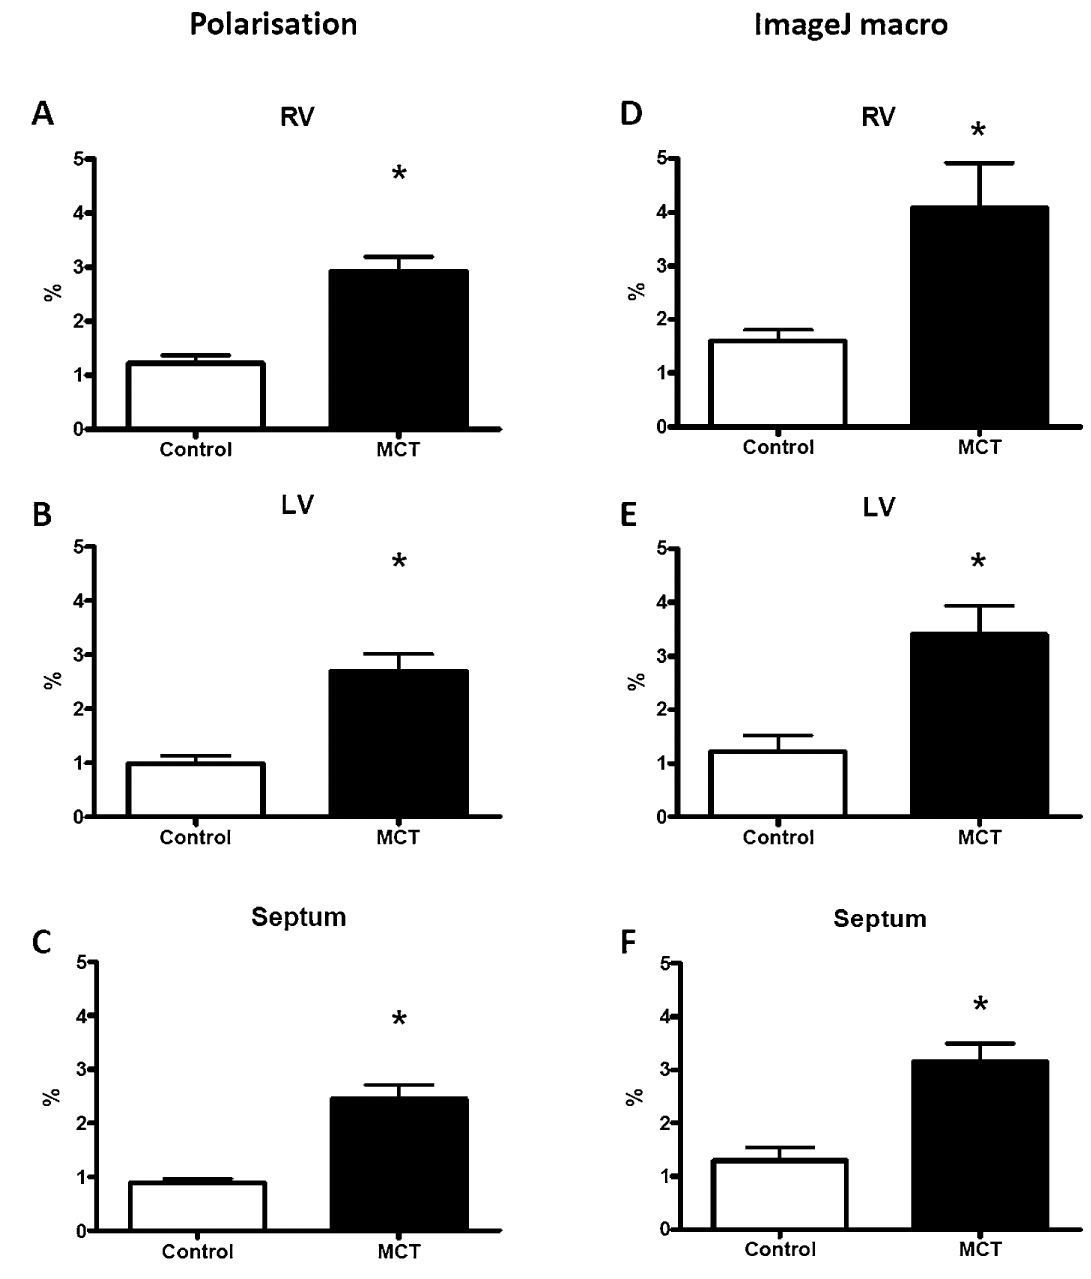
Fig. 4. Polarisation and ImageJ analyses showed that hearts of PH rats revealed more fibrosis compared to control. Note the increase in collagen content was not limited to the RV only, but was also found in the LV and the septum of these hearts. Note also that ImageJ analyses detected more fibrosis than the method of